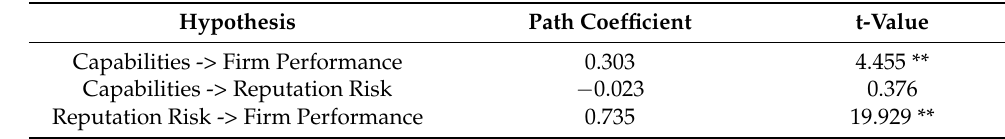
Table 4. Path coefficients, Observed t-statistics, and results for all hypothesized